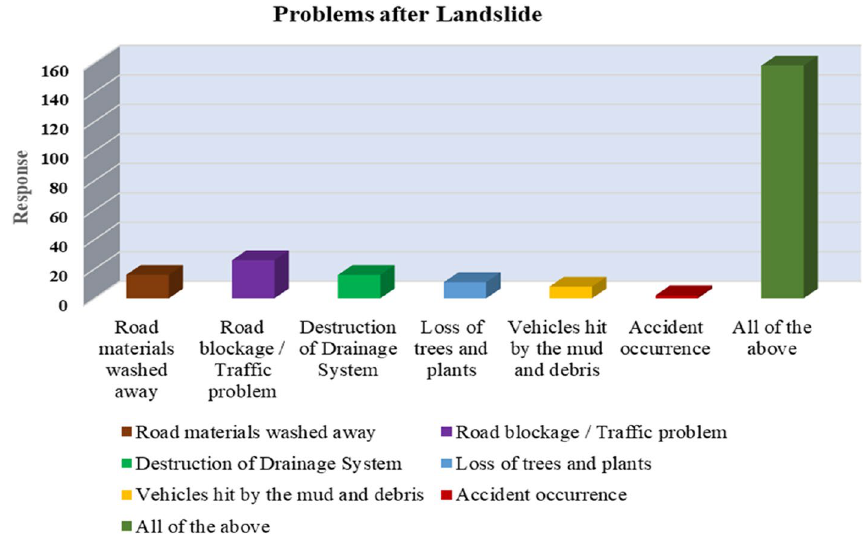
Fig. 1 Major problems after landslide